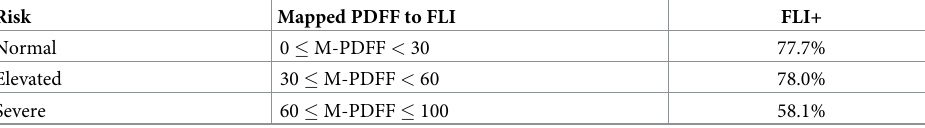
Table 5. Percentage of predicted FLI+ values with lower absolute error compared to original computed FLI.